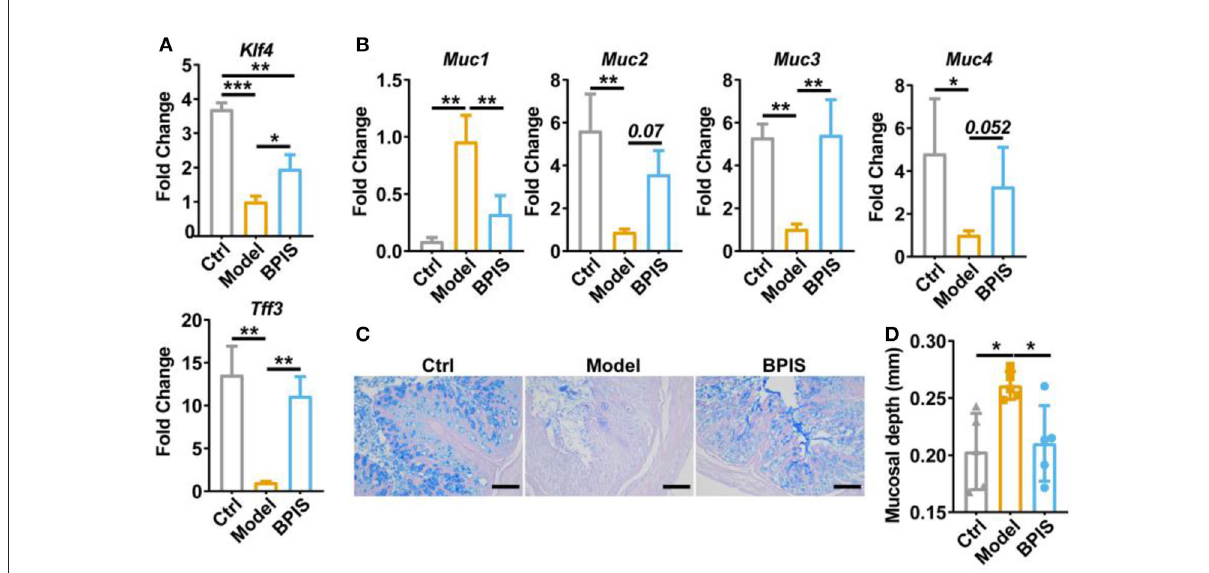
FIGURE3 BPIS ameliorated mucus disruption and goblet cell depletion. (A,B) , qPCR analysis for expression of goblet cell maturation markers Tff3 and Klf4 (A) and mucin genes Muc1, Muc2 , Muc3, and Muc4 (B) . (C) Representative images of alcian blue-stained colonic sections, Scale bars, 100 µ m. (D) Muscular layer width in the colon of mice was quantified. Data are presented as the means ± SD ( n ≥ 5) and were analyzed by an ordinary one-way ANOVA with Tukey’s multiple comparisons. * p < 0.05, ** p < 0.01, *** p <